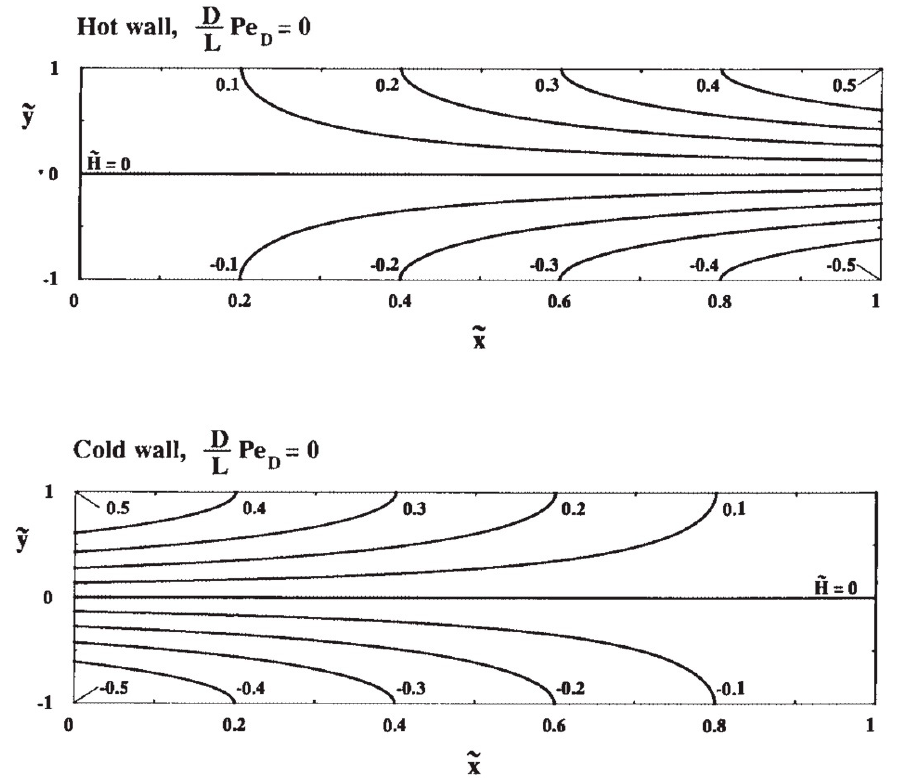
Figure 13. Heatlines in the fluid entering a duct with hot walls (top) and cold walls (bottom) [135,137].